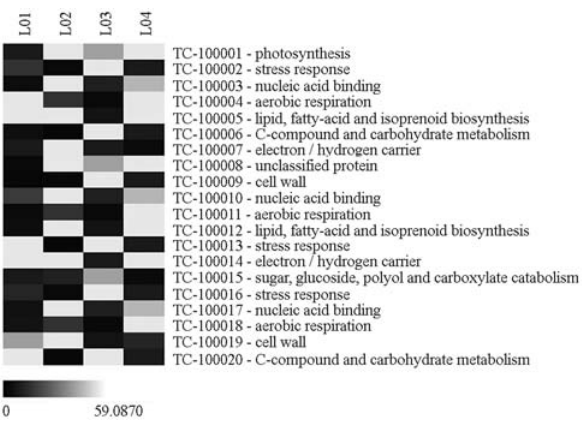
Figure 2 - Assessment of some Citrus sinensis differentially expressed genes through Digital Northern. The rows are the tentative consensi (TC), and the columns are the libraries used to perform the clusterization; in this example, four different fruit development stages were used. For a given tentative consensi and column, the intensity of color denotes its relative abundance, taking into account the number of composing reads and the size of the